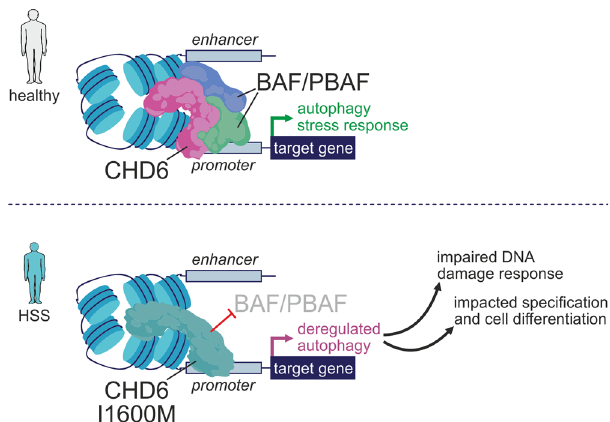
Fig. 4 The I1600M CHD6 mutation hinders co-factor recruitment at autophagy gene promoters. a In silico rendering of the second putative SANT-SLIDE domain structure for wild-type and mutant CHD6 (based on the published Chd1 SANT-SLIDE structure 7 ) and zoomed views around the I1600M mutation (bottom). b NanoDSF melting pro fi les ( fi rst derivative of the 350/330 nm ratio; n = 3 independent runs) of FLAG-tag puri fi ed wild-type (dark blue) or I1600M (light blue) full-length CHD6 along a temperature gradient. *: signi fi cantly different mean; P < 0.01, two-tailed unpaired Student ’ s t -test. Scattering pro fi les along the gradient reveal no difference in aggregation (inset). c Overexpression of wild-type or mutant CHD6 cloned into a piggybac vector (left) in iPSCs exempli fi ed by Venus-GFP levels or anti-HA western blotting of CHD6 (right); β -tubulin provides a control. Bar, 25 μ M. d Network representation of GO terms associated with proteins co-purifying with wild-type CHD6 in steady-state iPSCs. e Heatmaps showing enrichment or depletion of GO terms/ pathways linked to CHD6-interacting proteins upon starvation, etoposide treatment or in steady-state wild-type and mutant iPSCs. f Western blot of SMARCC1 co-immunoprecipitating with overexpressed wild-type (wt) or mutant CHD6 (mut) in iPSCs; anti-HA and anti- β -tubulin blots provide a control. g Representative genome browser views for SMARCA4/-B1/-C1 ChIP-seq aligned to CHD6 ChIP-seq from wild-type (wt) and monoallelic mutant iPSCs (mut) around the DNAAF1 and LAMP1 promoters. h Line plots showing average SMARCA4/-B1/-C1 ChIP-seq signal pro fi les in the 4 kbp around CHD6 peaks; signal from mutCHD6 ChIP-seq provides a reference. i Venn diagram (left) showing overlap of genes bound by mutCHD6 and SMARCA4/-B1/-C1. Bar plots (right) showing signi fi cantly-enriched GO terms associated with the 243 shared genes. *: signi fi cantly more than expected by chance; P < 10 − 3 , hypergeometric test. j Bar plots showing changes in SMARCC1 or ACTL6A ChIP-qPCR signal (fold enrichment over wt ±SD; n = 2 independent experiments) from heterozygous (white) or monoallelic mutant iPSCs (blue). k Heatmaps (left) showing changes in mRNA levels (log 2 ) in response to iPSC starvation at genes co-bound by CHD6 and SMARCA4/-B1/-C1. Pearson ’ s correlation coef fi cients for each pair are shown. Bar plots (right) showing